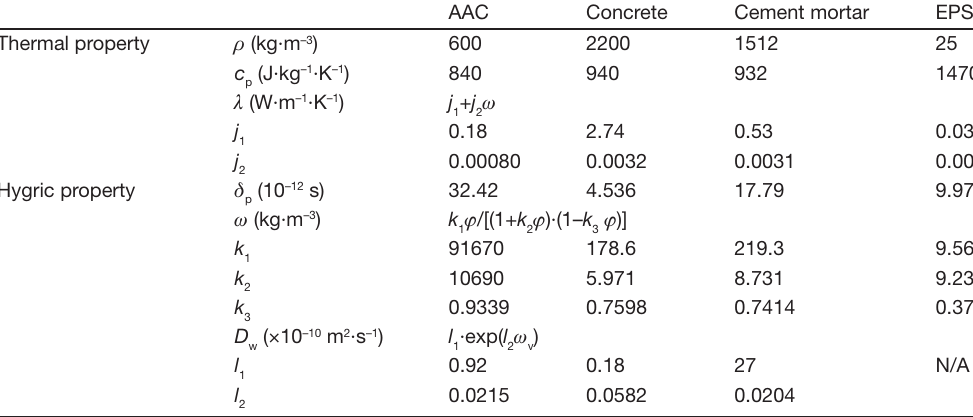
Table 1. Hygrothermal properties of the building